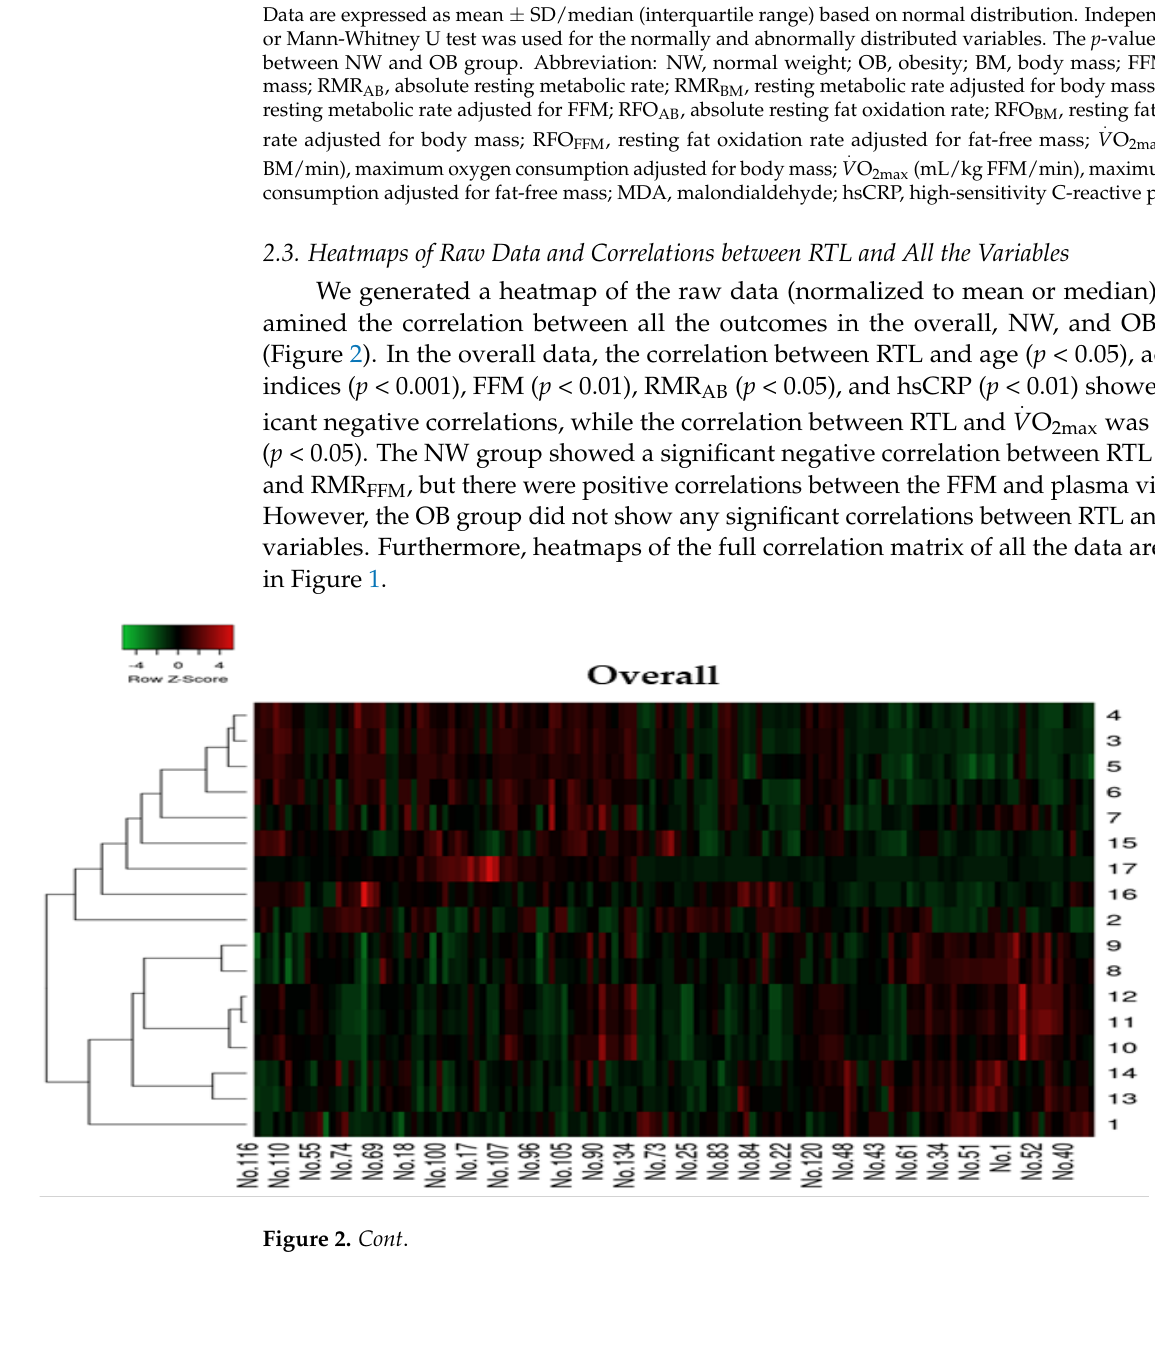
Figure 2. Heatmap of raw data (normalized to mean or median) and correlation of all the outcomes in the overall, NW, and OB groups. The colour red and green are representing the negative and positive correlations, respectively. Symbols: NW, normal weight; OB, obesity; Blood leukocyte relative telomere length = 1; age = 2; body mass index = 3; waist circumference = 4; body fat (%) = 5; fat-free mass = 6; RMR AB , absolute resting metabolic rate = 7; RMR BM , resting metabolic rate adjusted for body mass = 8; RMR FFM , resting meta- bolic rate adjusted for FFM = 9; RFO AB , absolute resting fat oxidation rate = 10; RFO BM , resting fat oxidation rate adjusted for body mass = 11; RFO FFM , resting fat oxidation rate adjusted for fat-free mass = 12; V ̇ O 2max (mL/kg BM/min), maximum oxygen consumption adjusted for body mass = 13; V ̇ O 2max (mL/kg FFM/min), maximum oxygen consumption adjusted for fat-free mass = 14; MDA, malondialdehyde = 16; hsCRP, high-sensitivity C- reactive protein = 17.